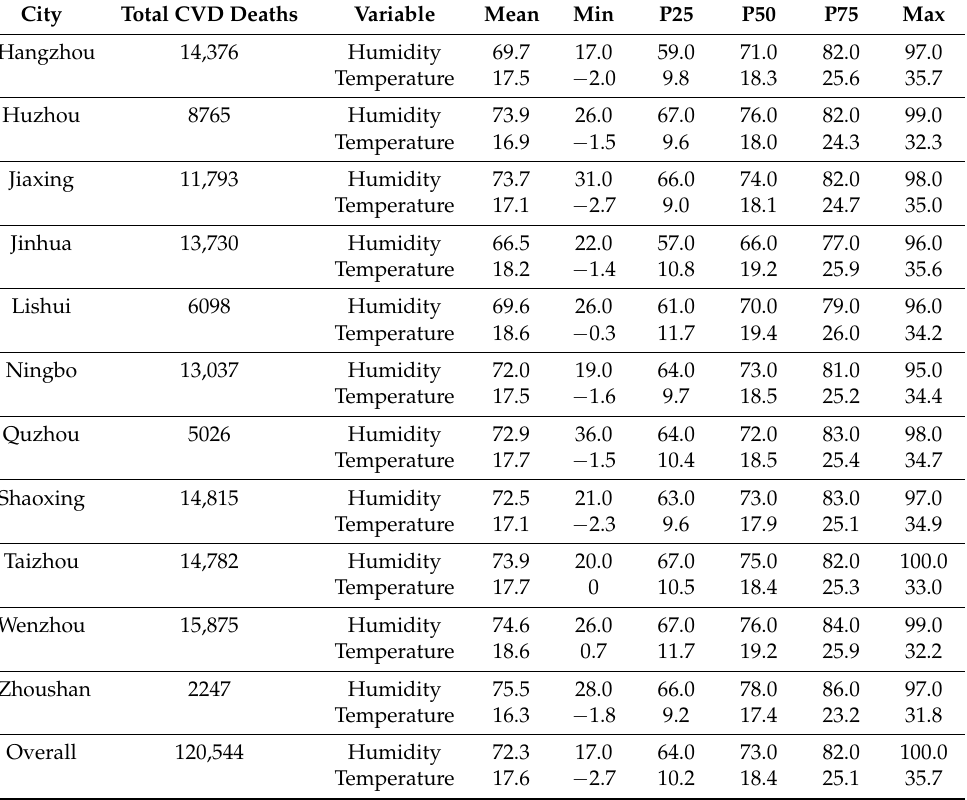
Table 1. Summary statistics for CVD deaths, daily mean temperature, and relative humidity in Zhejiang Province, China between 2010 and 2013.